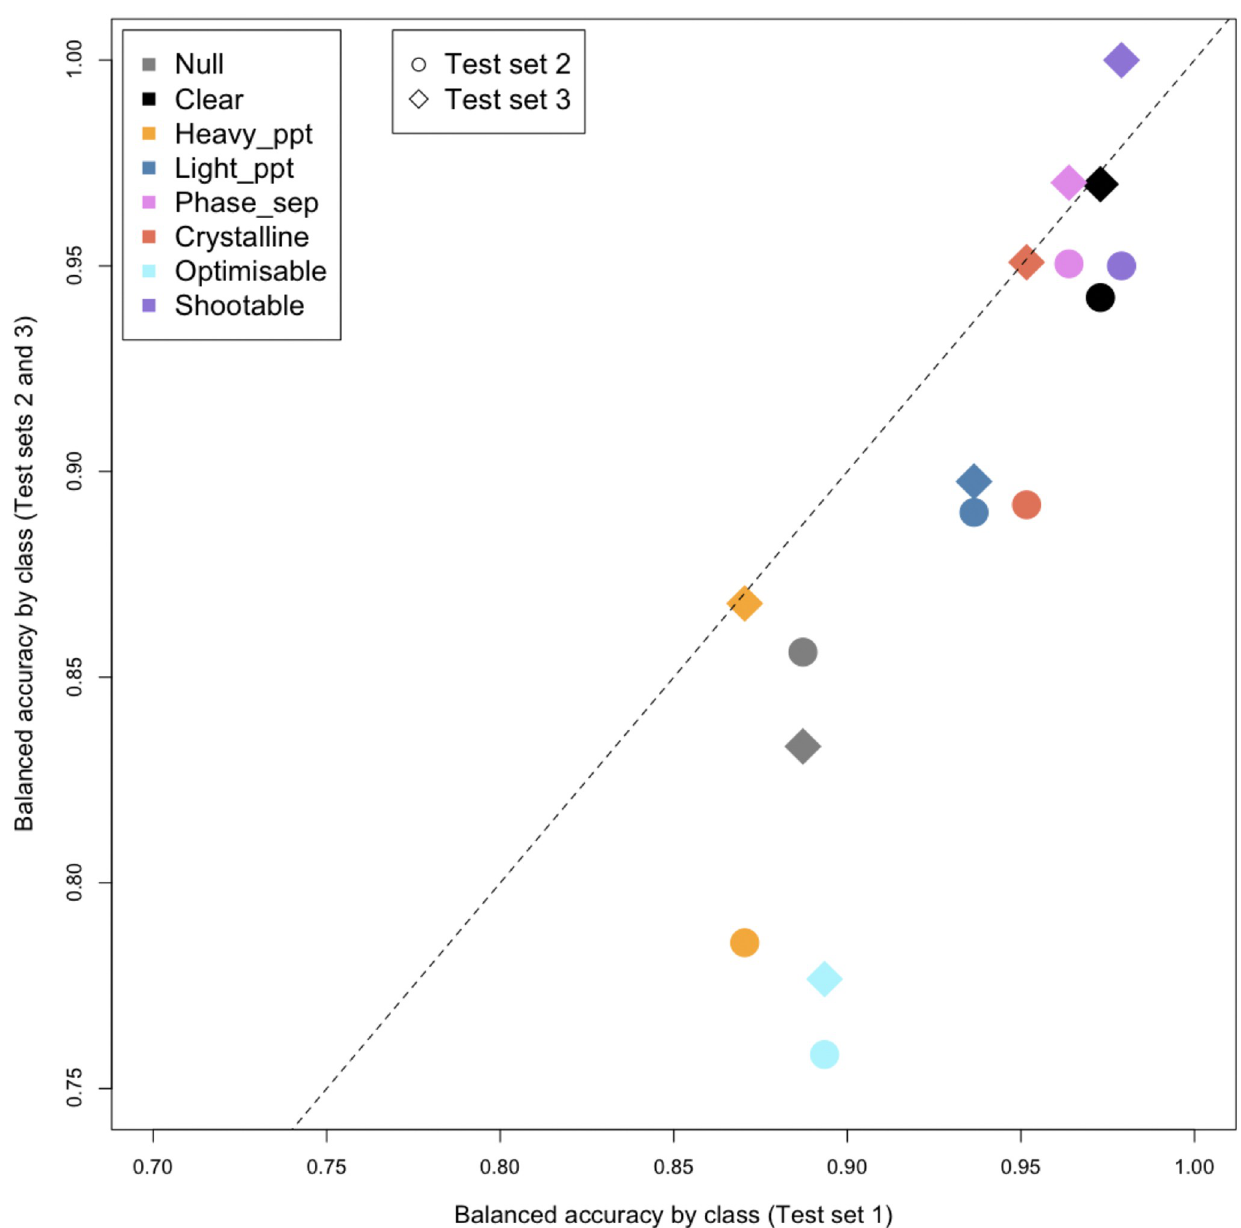
Fig 4. Comparison of Test set results by class. For each class, the balanced accuracy obtained for Test Set 1 is plotted against the balanced accuracy for Test Sets 2 and 3, identified by different symbols. The results shown were obtained using the DenseNet121 classifier.